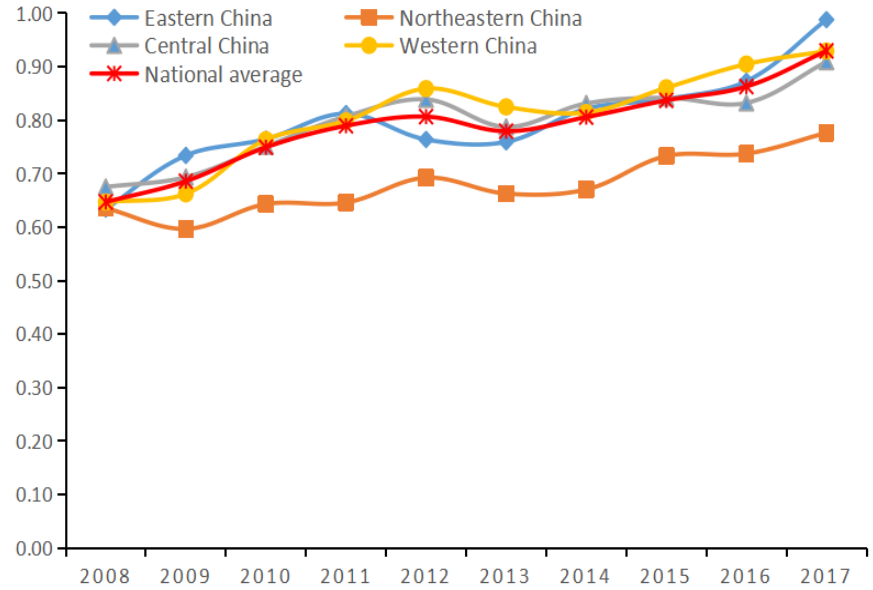
Figure 2. Change in the mean value of efficiency in the third stage from 2008 to 2017. From the overall analysis of the country (see Figure 2), after adjustment, the investment effi- ciency value of China’s environmental pollution control has increased significantly. The average efficiency value has increased from 0.654 in the first stage to 0.789, an increase of 20.6%. This